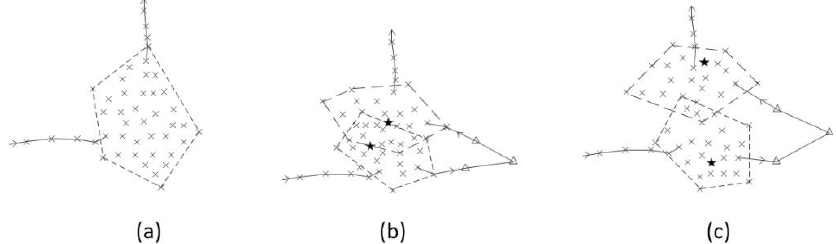
Figure 3. Sequence merging: ( a ) a well clustered stop sequence; ( b ) a stop sequence merged by Criterion 1; and ( c ) a stop sequence merged by Criterion 2.